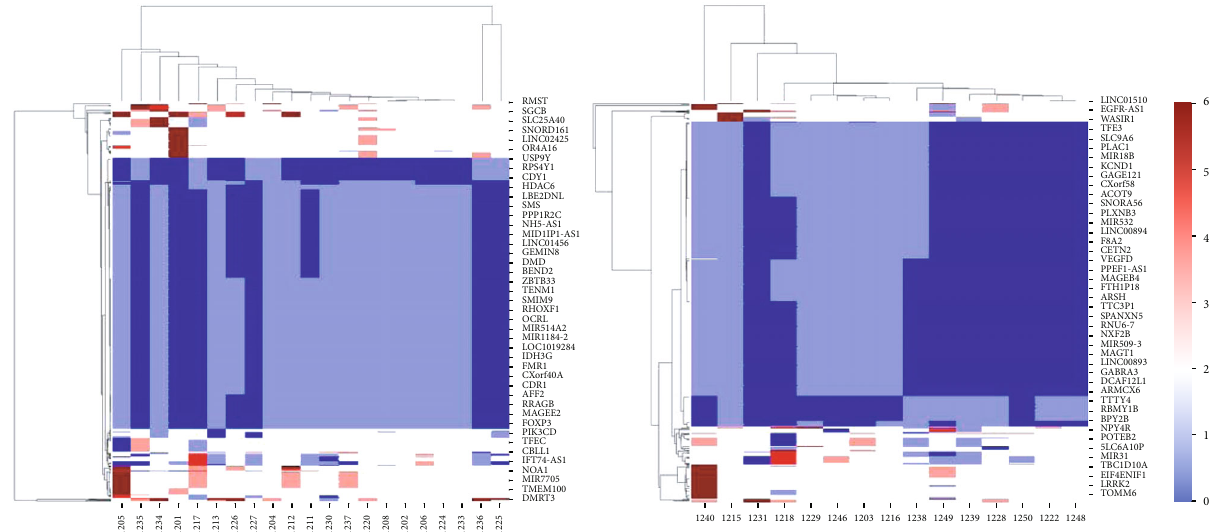
Figure 3: The gene list of screened genes with CNV in GBM and